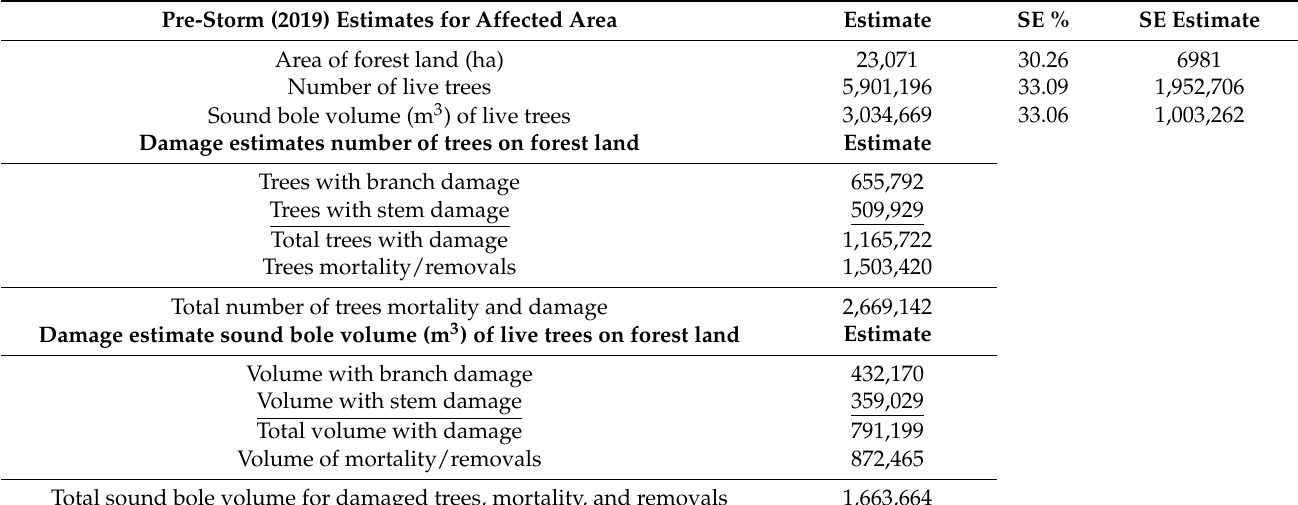
Table 3. Pre-storm and damage estimates in number and volume of trees ( ≥ 12.7 cm/5 in d.b.h.) on forest land affected by the August 2020 Midwest Derecho, Iowa, USA. Sampling errors represent ± 1 SE.